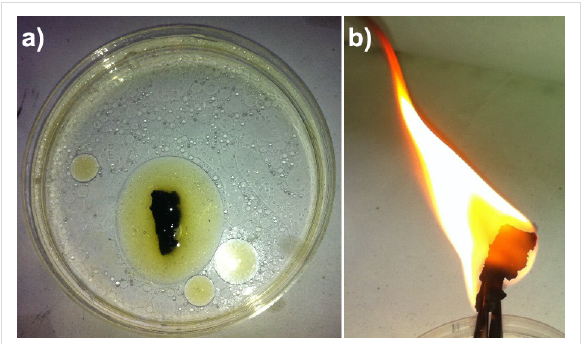
Figure 6: Burning and reuse of the CNT-sponge. Photograph of the starting of the oil-adsorption process (a), and burning after the sponge got saturated with oil